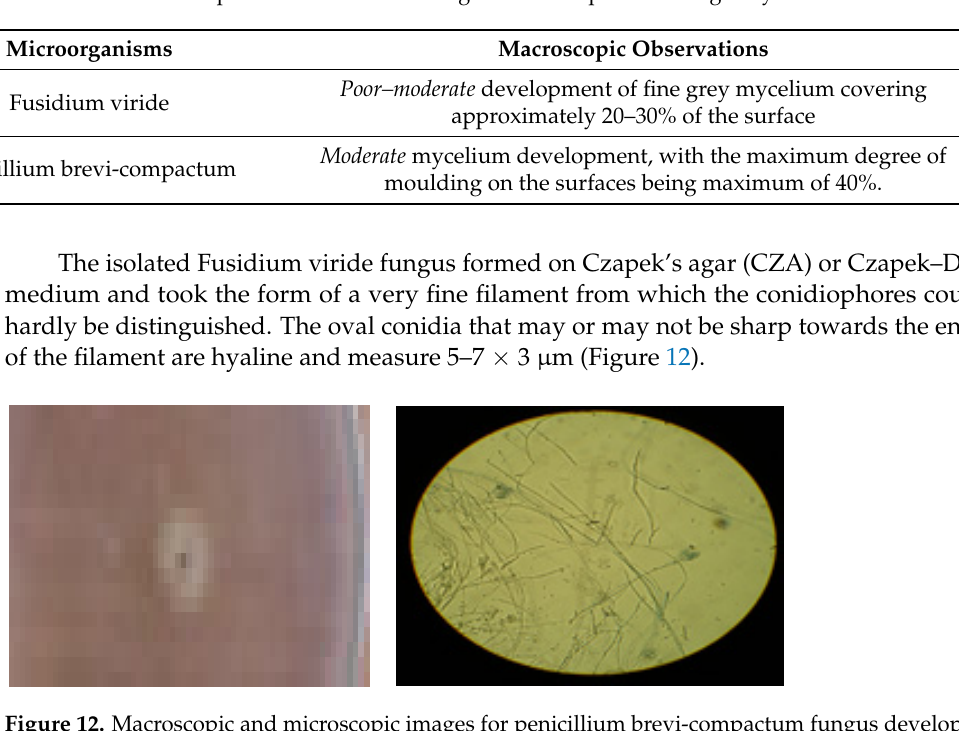
Figure 11. Macroscopic and microscopic images of the APDMS-CL sample on the surface of which the fungus Fusidium viride developed. Table 3. The macroscopic observations on the degree of development of fungal mycelium on APDMS-CL.